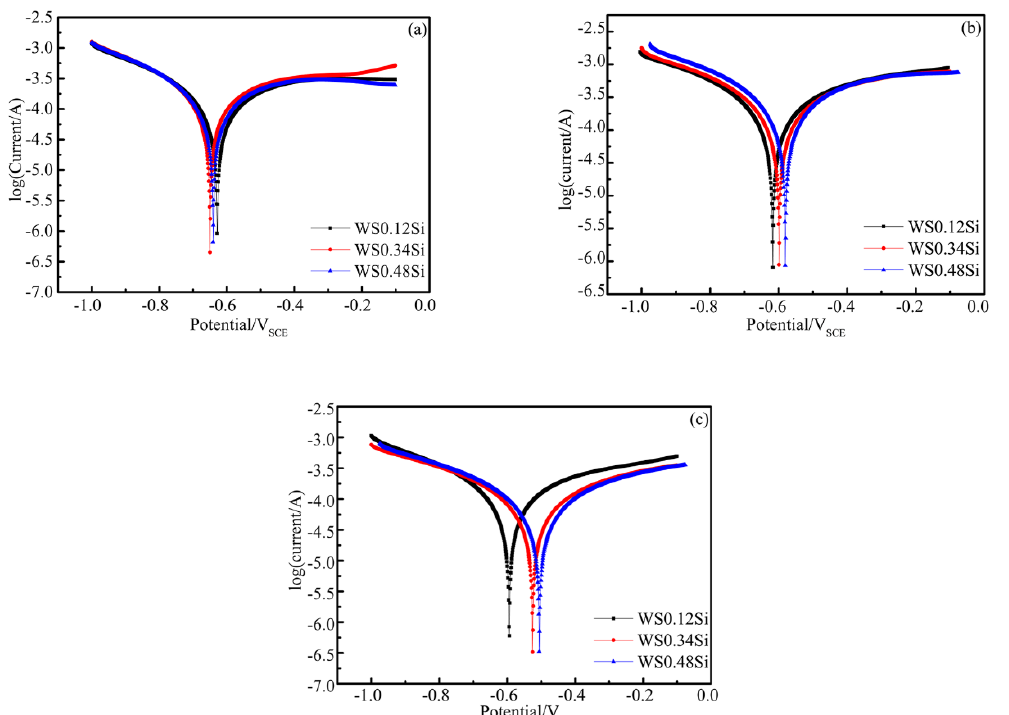
Figure 7. Polarization curves of three experimental steel groups at ( a ) 6th cycle, ( b ) 30th cycle, and( c ) 120th cycle.